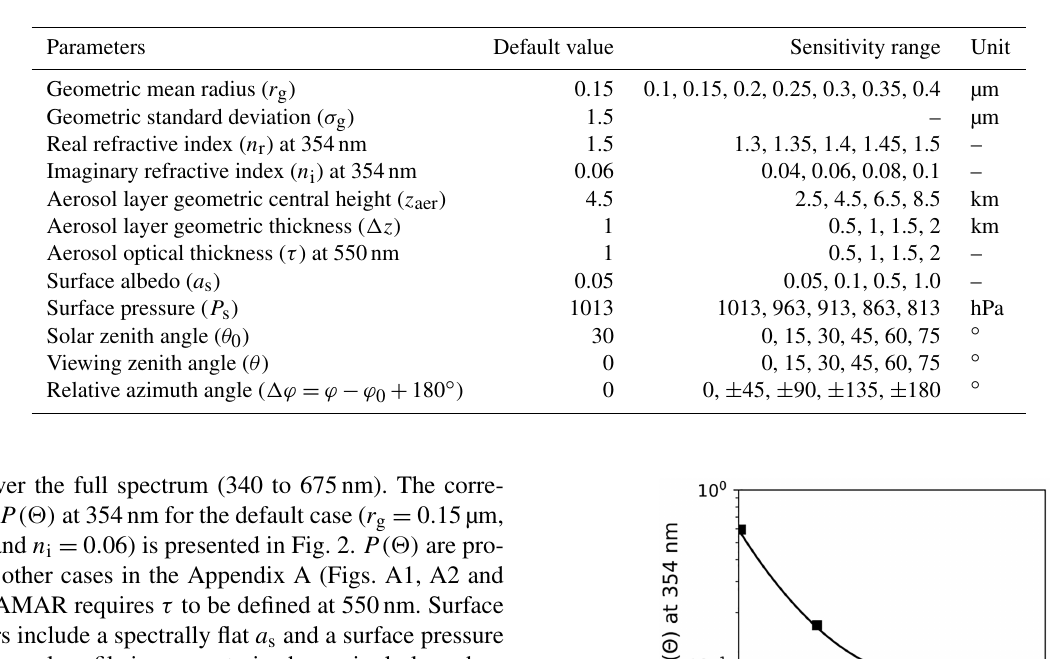
Table 1. Parameters used in sensitivity studies.